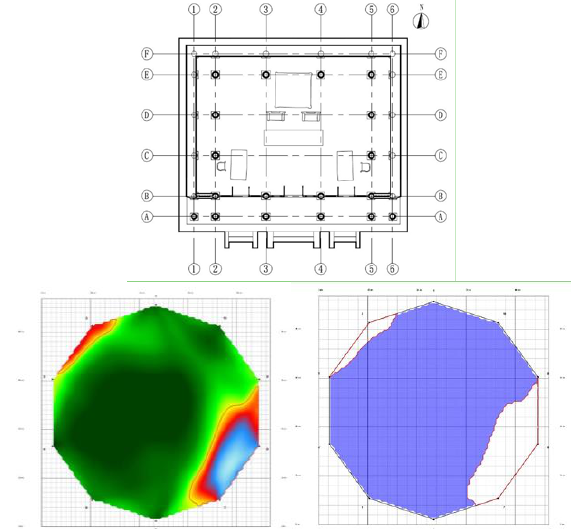
Figure.7 Stress wave pseudo image of D5 pillar of the main hall